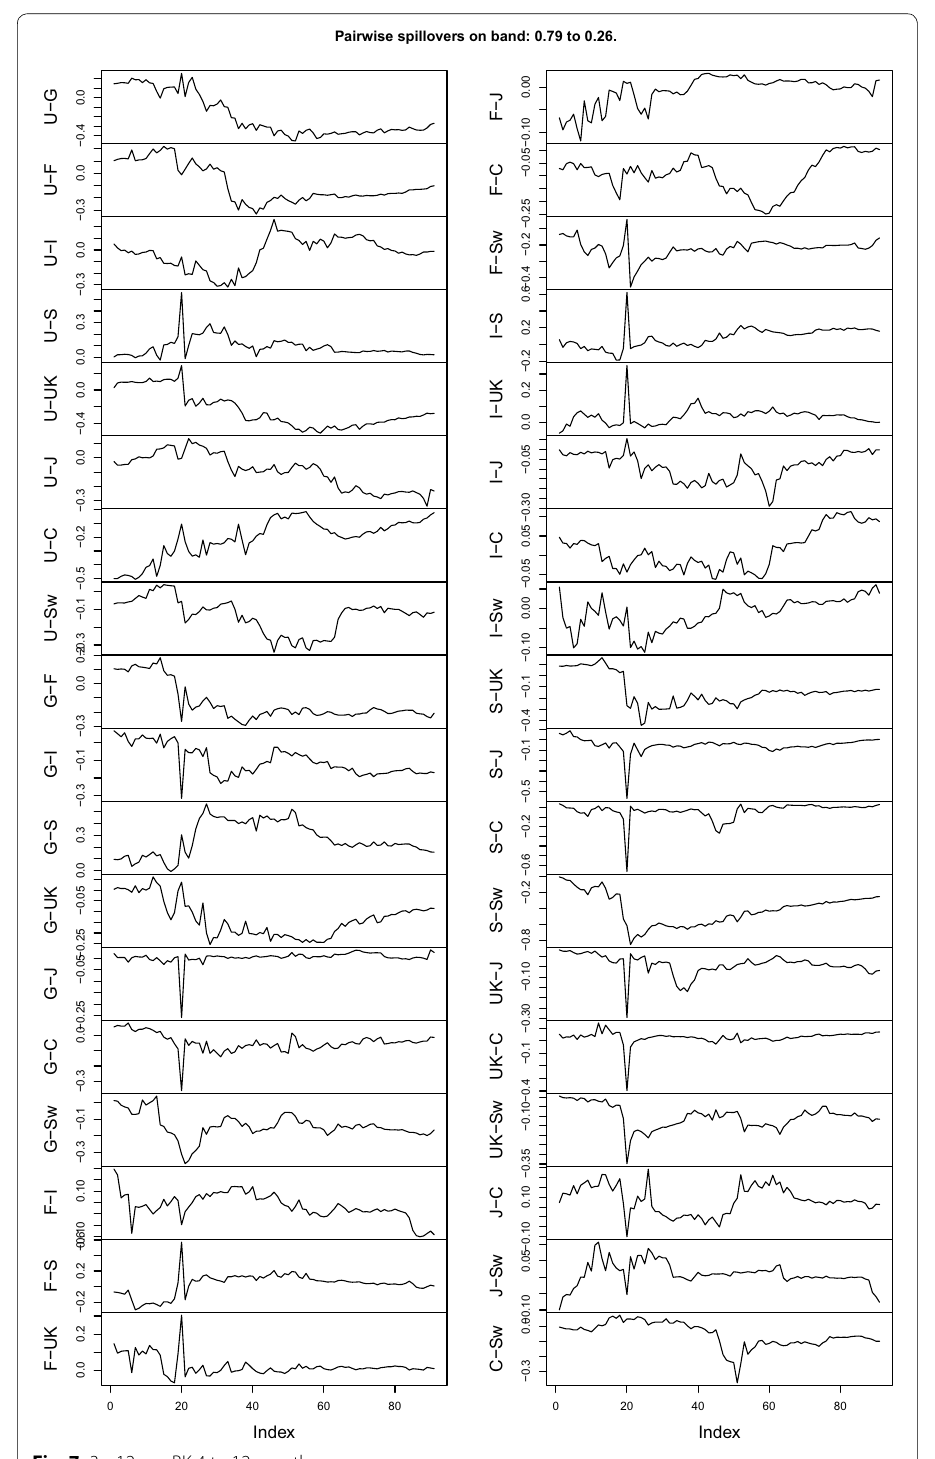
Fig. 7 3m12m—BK 4 to 12